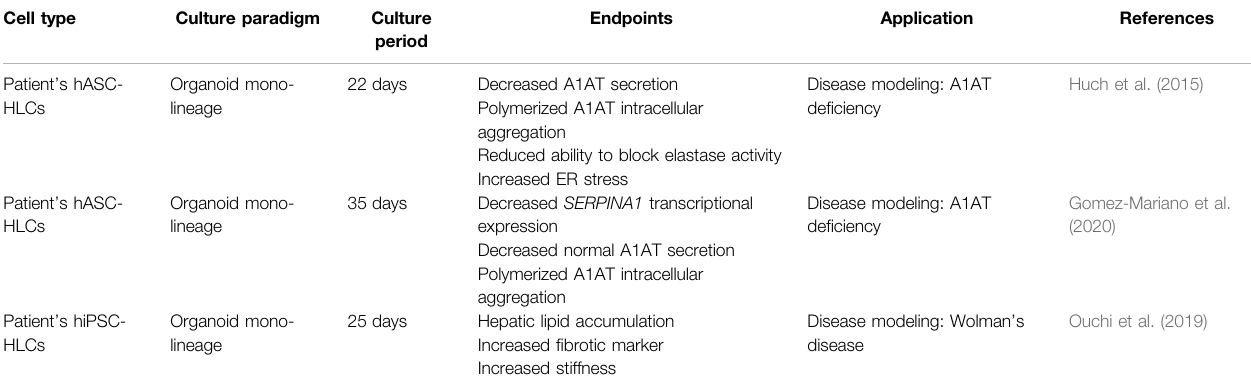
TABLE 5 | Selected 3D monogenic liver disease models established from different cell